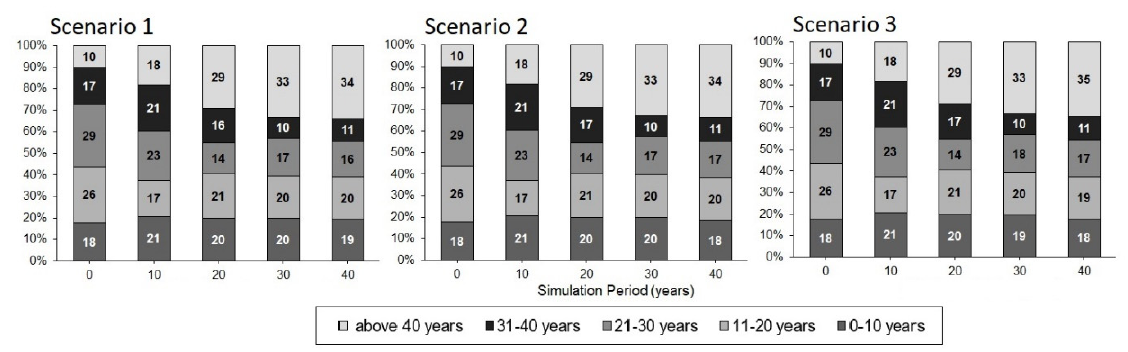
Figure 7. Distribution of area occupied by each age class within the sourcing radius (90 km) of the pulp mill during different years of the simulation period. Scenarios 1, 2 and 3 are differentiated in